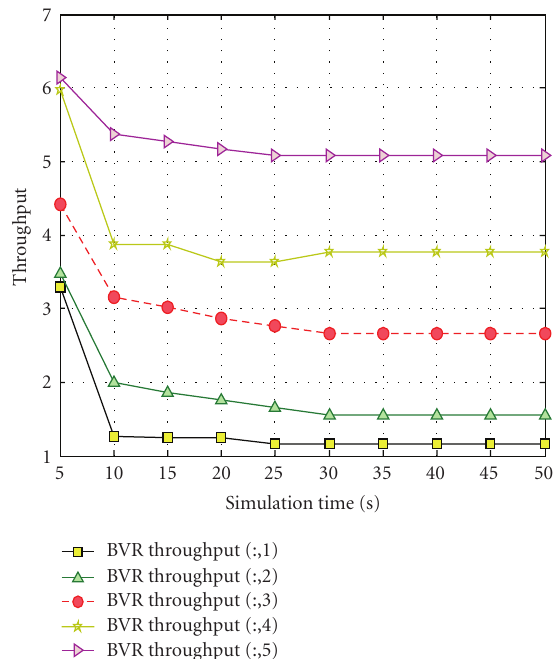
Figure 13: The simulation time and throughput.